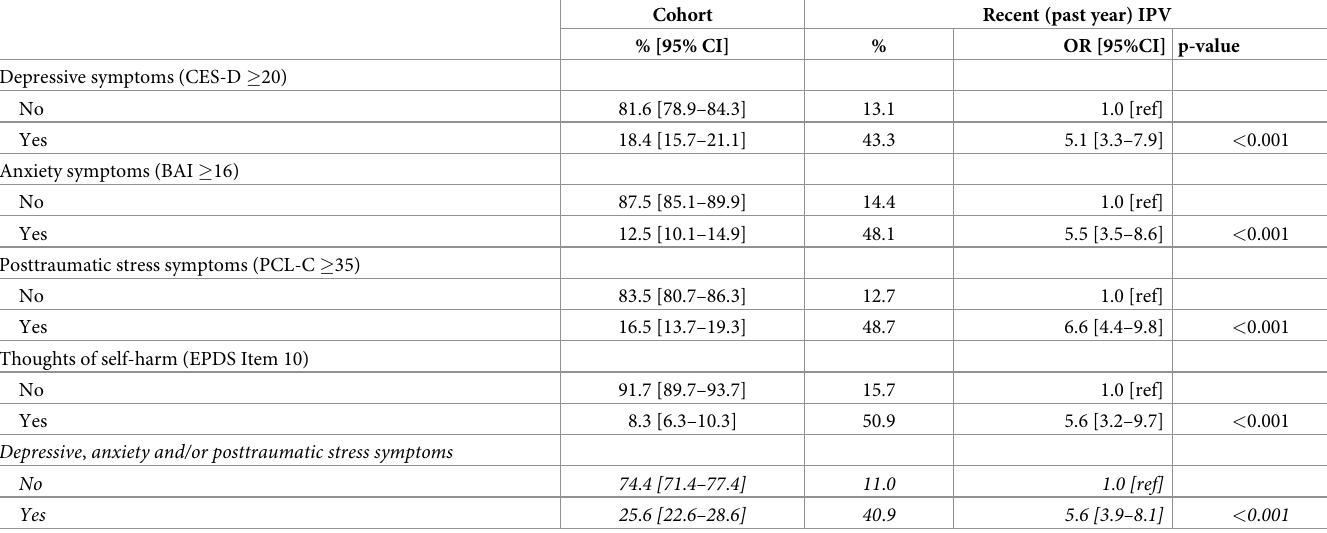
Table 2. Likelihood of experiencing recent IPV among those with and without mental health symptoms at ten years postpartum (n = 1507).